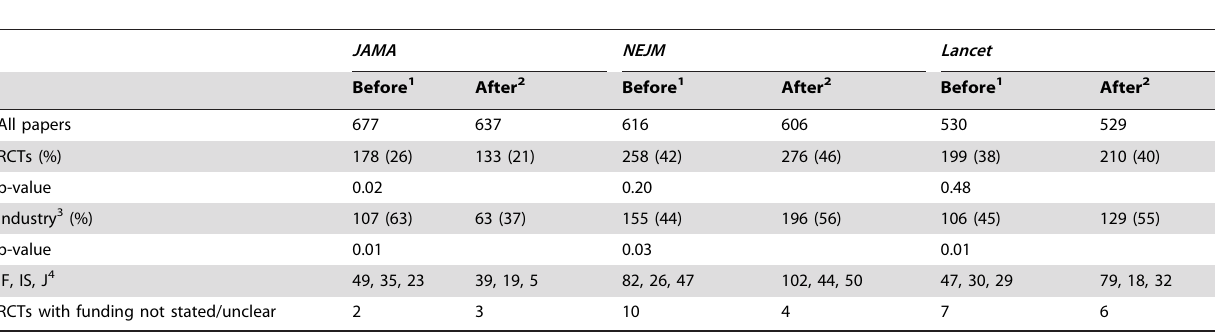
Table 1. Number of randomized trials (RCTs) and studies with commercial funding published in JAMA, NEJM and The Lancet in the 3 years before and after JAMA’s policy on independent statistical analysis (July